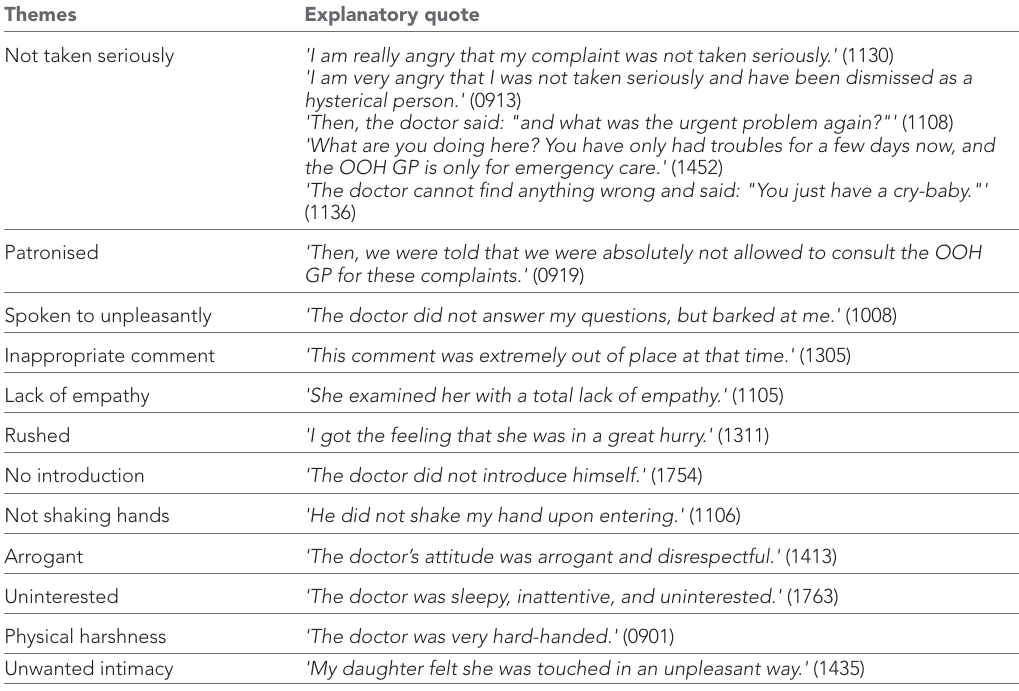
Table 3 Explanatory quotes about complaints pertaining to professionalism